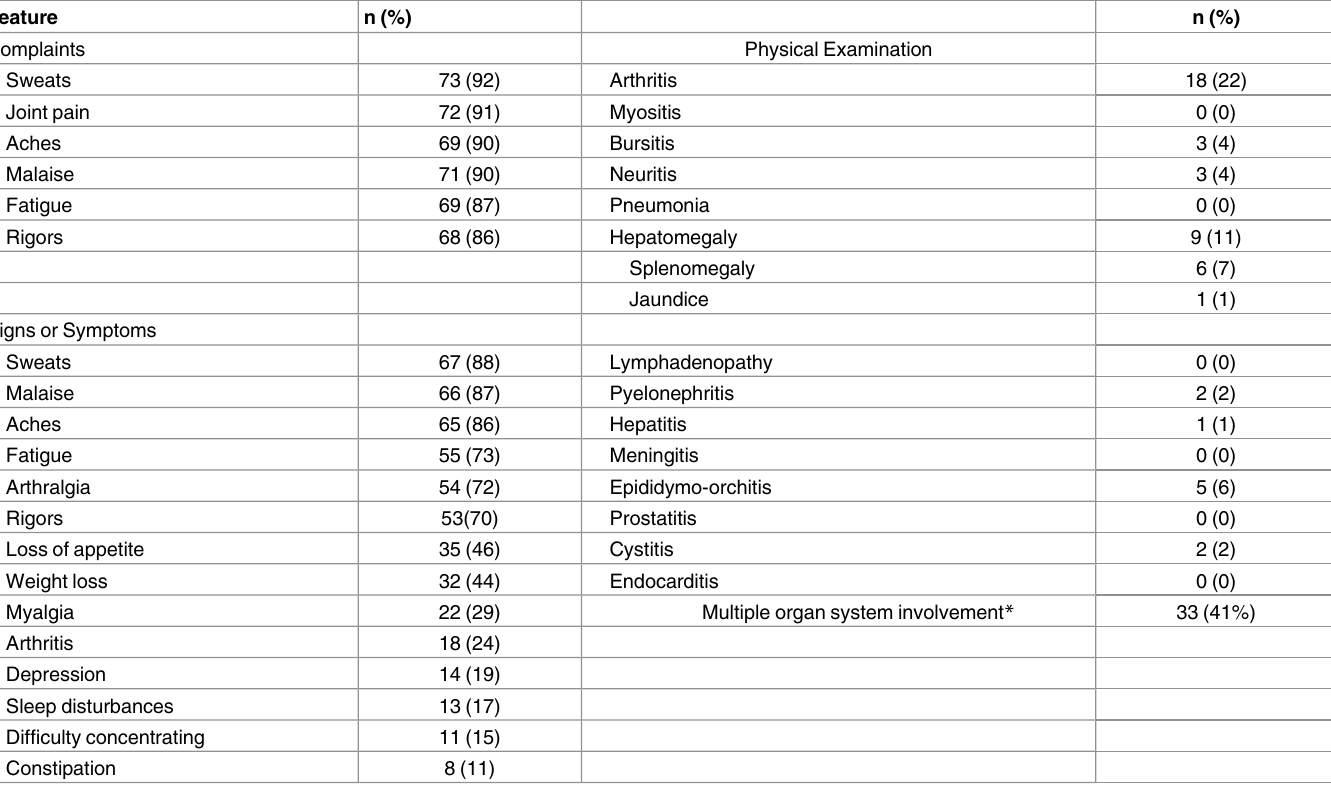
Table 2. Complaints, signs/symptoms, and physical examination of the study